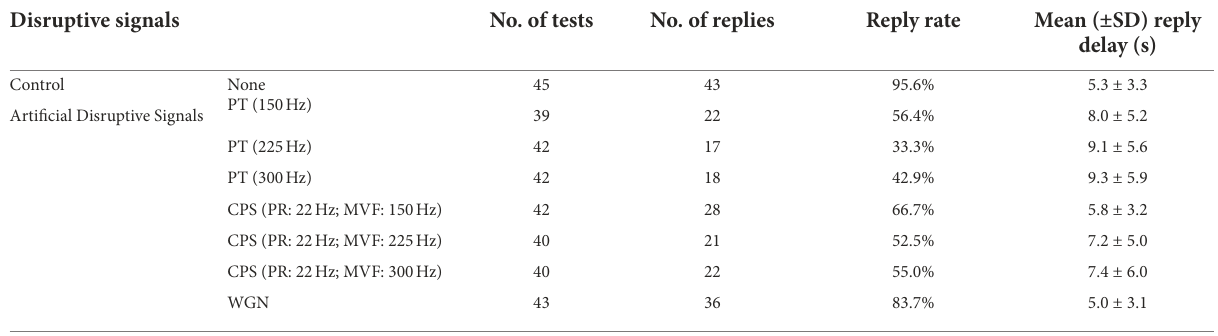
TABLE 1 Screening results of BPH courtship-specific disruptive signals. Disruptive